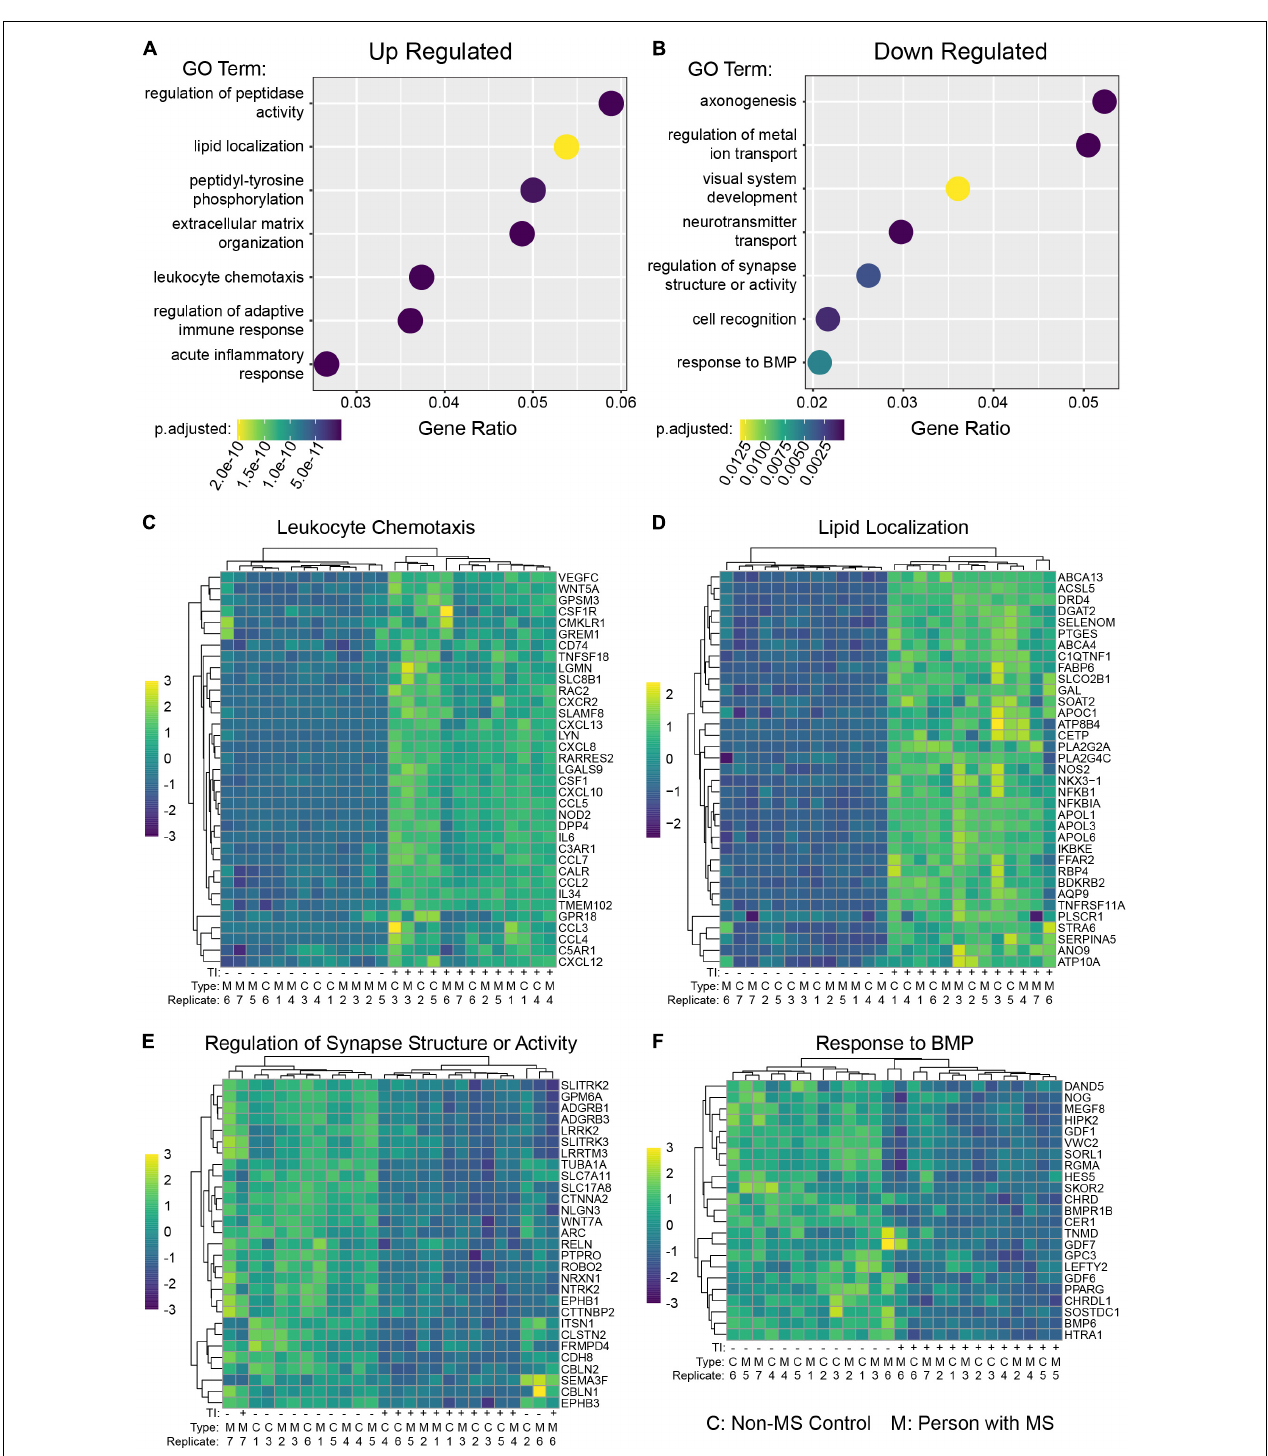
FIGURE 2 | Gene ontology enrichment analysis of astrocytes following TI stimulation suggests shifts in function. GO enrichment analysis was performed on genes with a Log 2 Fold Change value greater than 1 (up-regulated) or less than –1 (down-regulated) and adjusted p -value less than 0.05. A selection of enriched terms are shown in (A) (up-regulated pathways) and (B) (down regulated pathways), where the X -axis indicates the ratio of genes associated with that term to the total number of genes up or down regulated. BMP is bone morphogenic protein. Heatmaps showing relative expression values of genes associated with selected enriched GO terms in the up-regulated genes (C,D) and down-regulated genes (E,F) . Unsupervised clustering of genes is shown along left side and of samples along top.